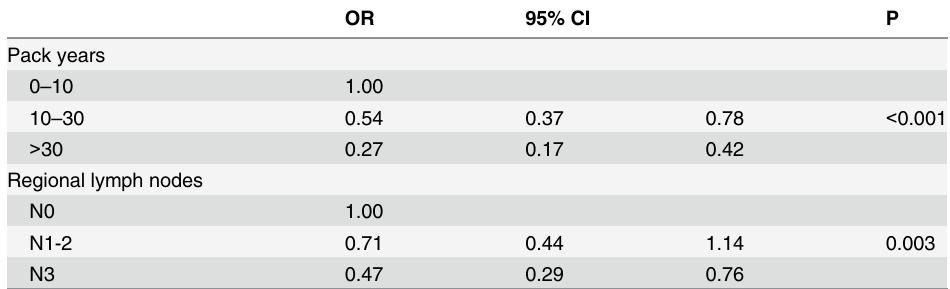
For patients who provided both histology and cytology samples, test results from histology samples were